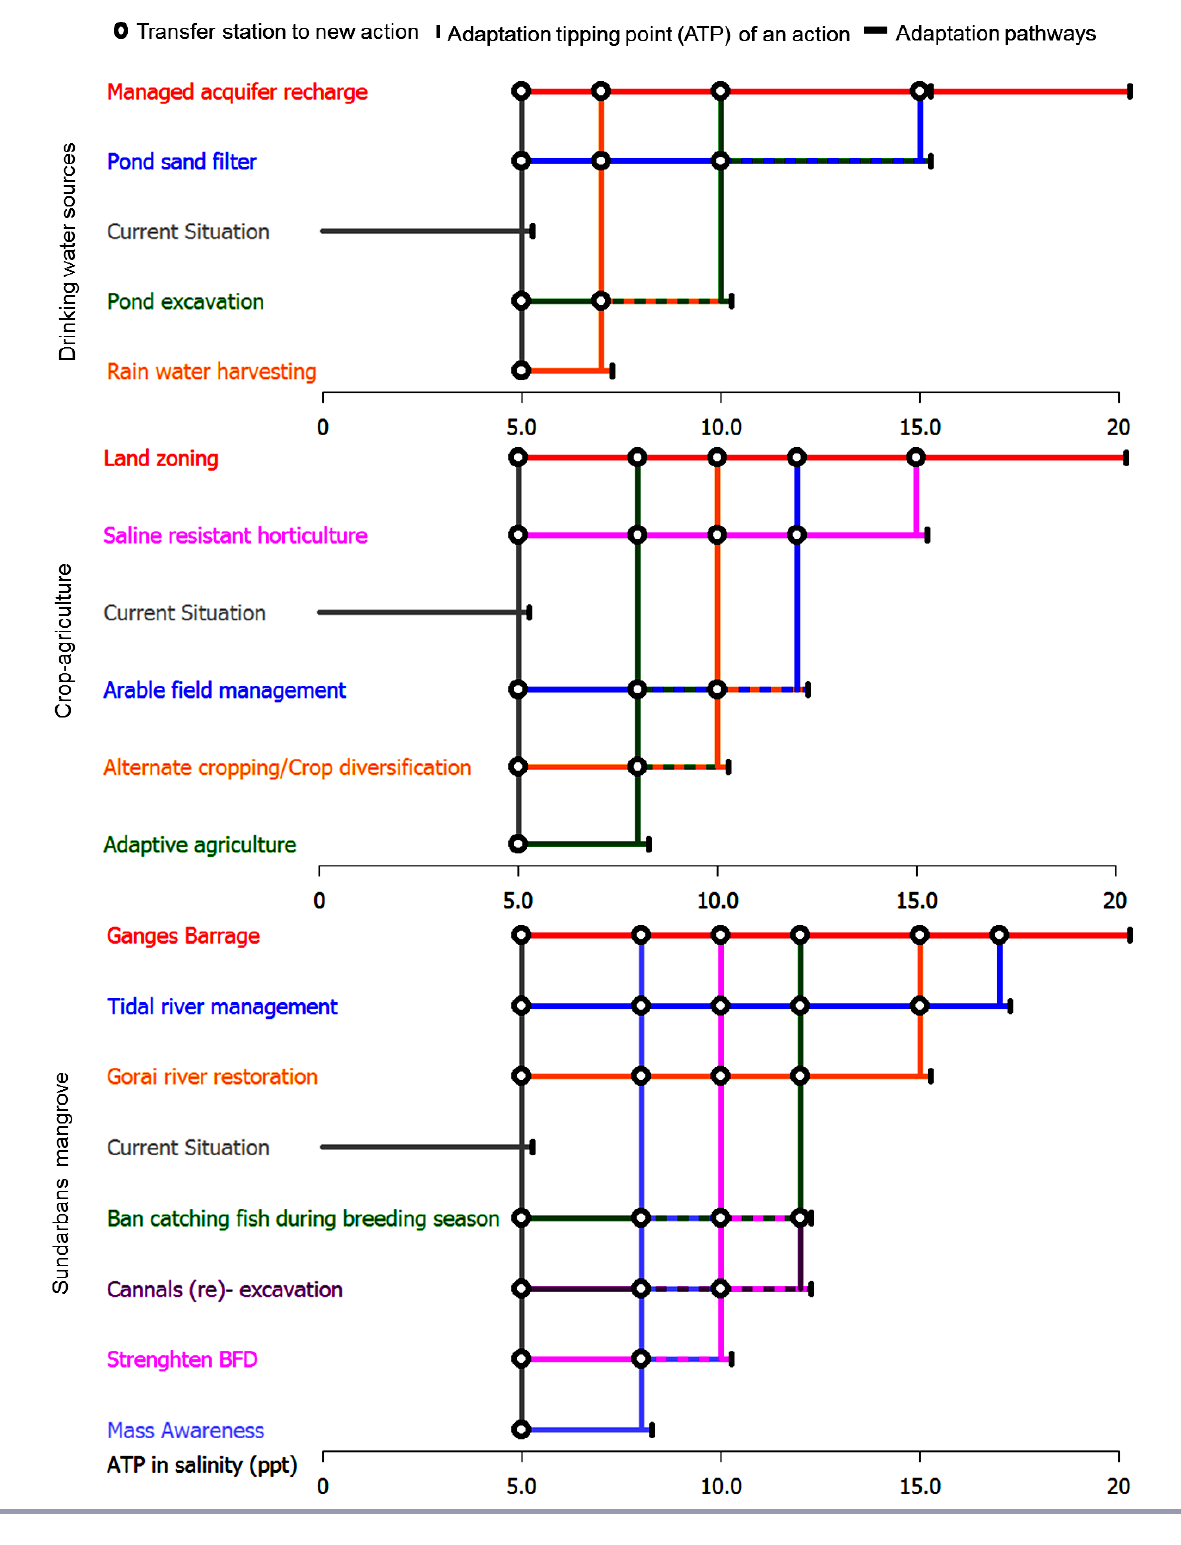
Fig. 7 . Adaptation pathway map for the most affected coastal